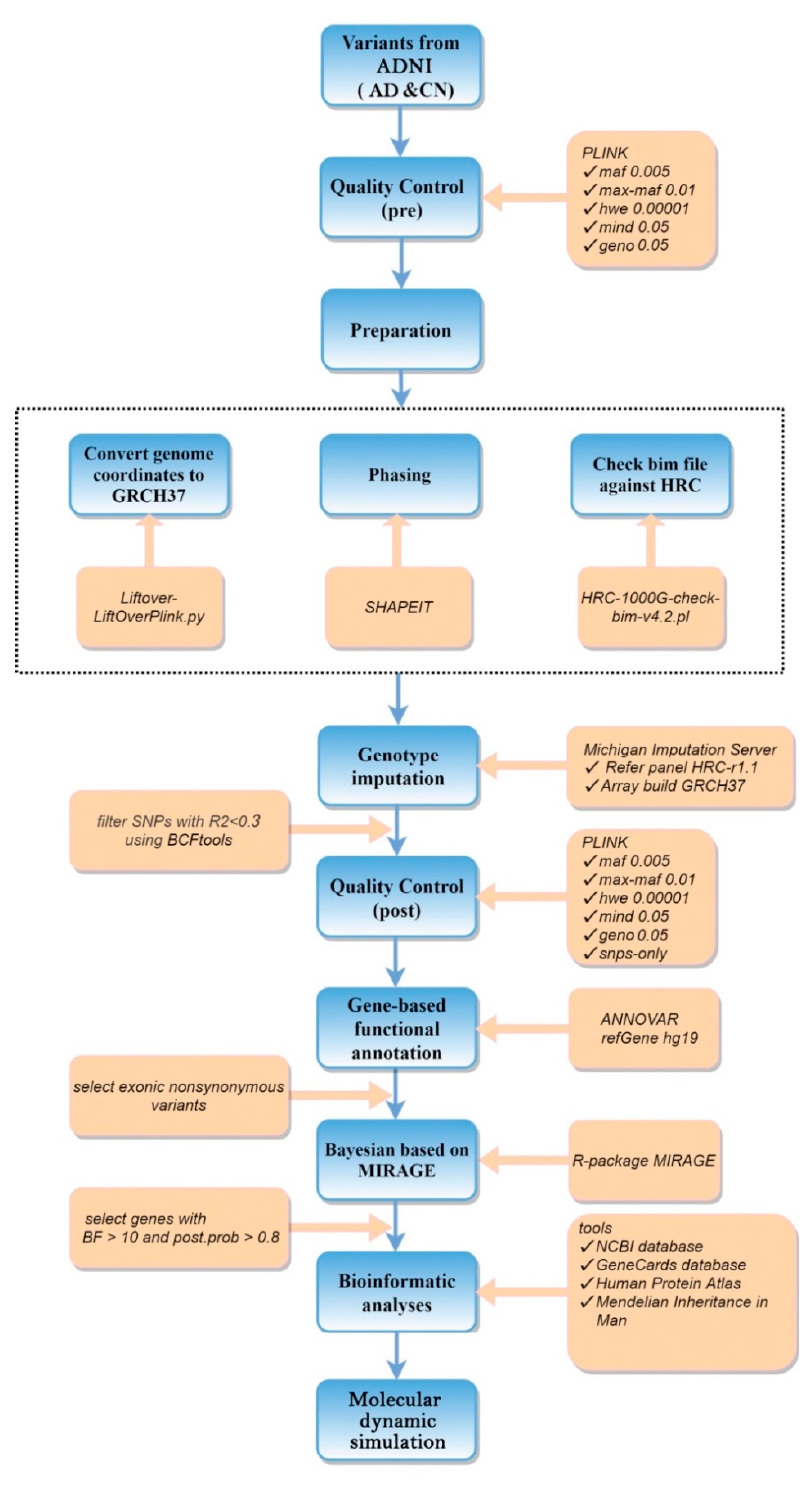
Figure 1. rare variant association studies